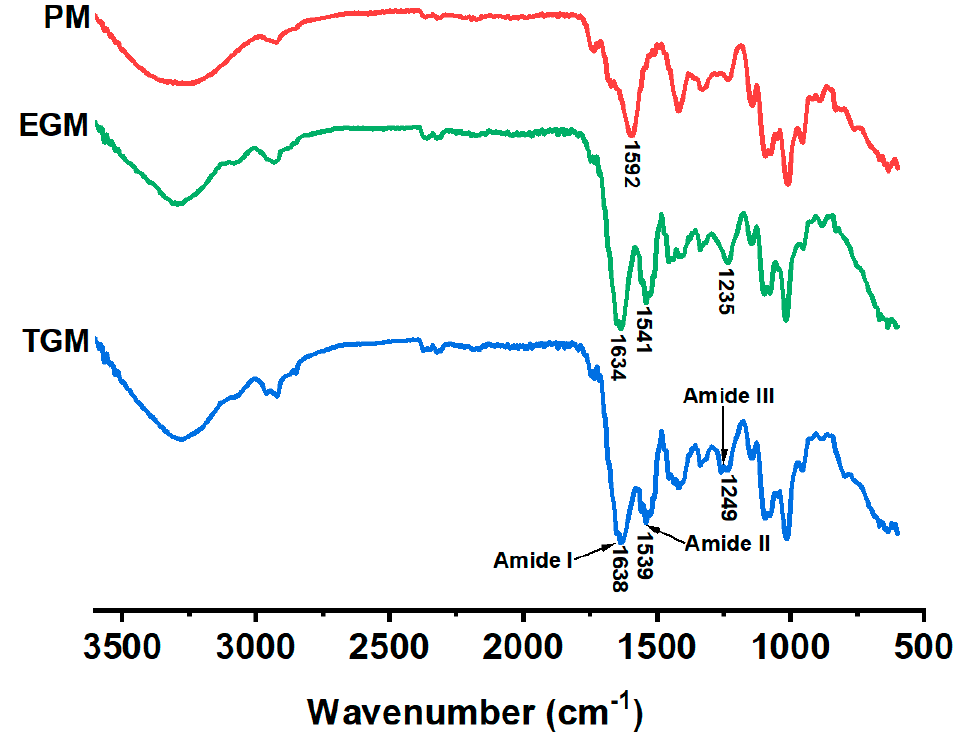
Figure 4. ATR ‐ FTIR spectrum of different types of microspheres. Figure 4. ATR-FTIR spectrum of different types of